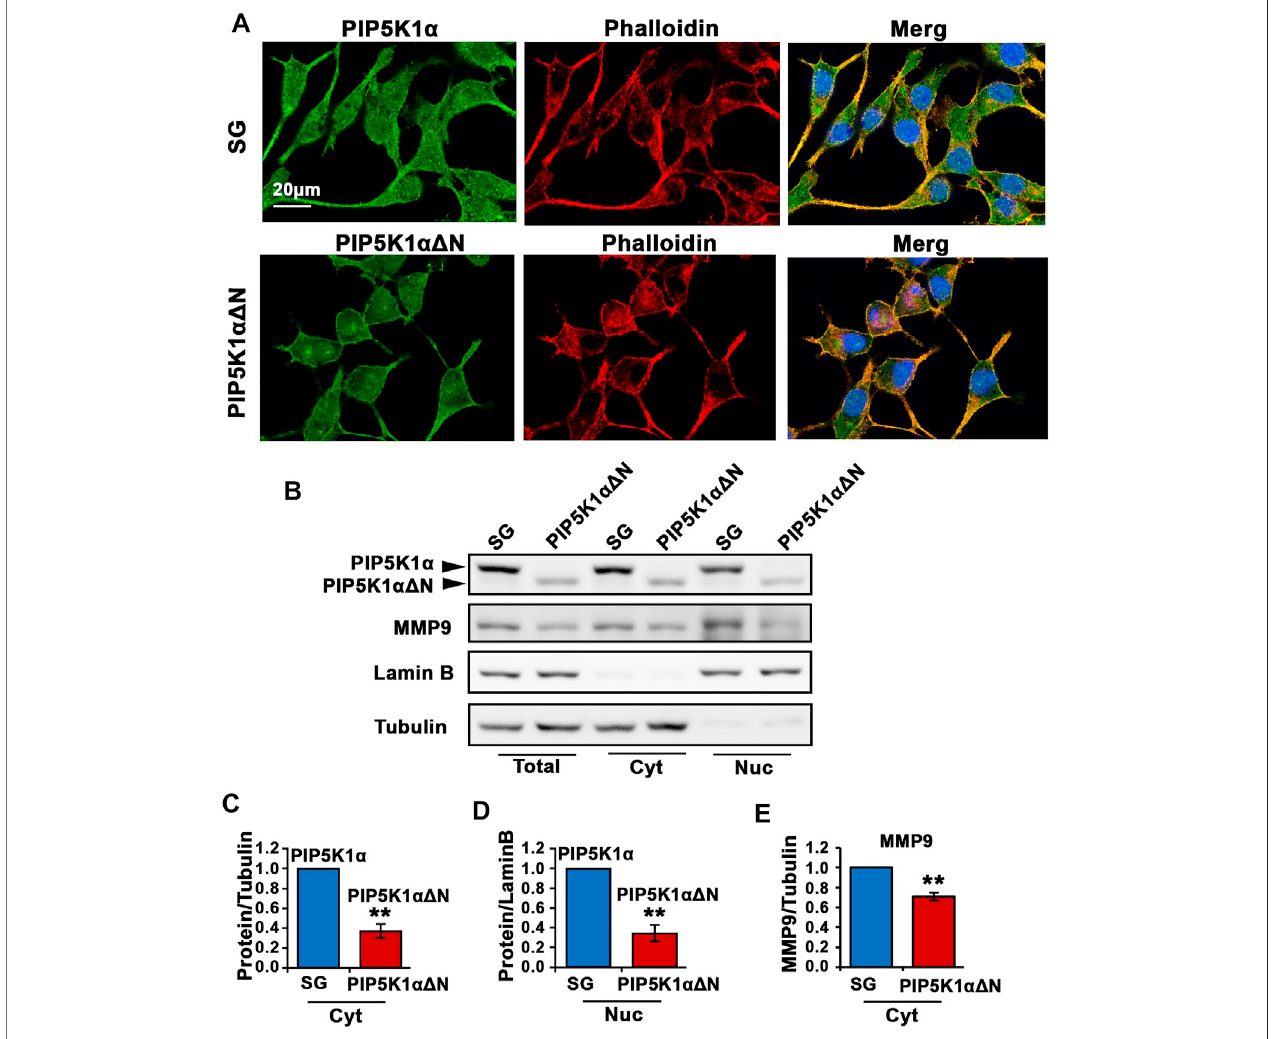
FIGURE 6 | The effect of N-terminal-truncated PIP5K1 α on migratory ability and subcellular components of PIP5K1 αΔ N cells. (A) Representative immuno fl uorescent imagesshowedthesubcellular localizationofPIP5K1 α andPIP5K1 αΔ NingreeninSGand PIP5K1 αΔ Ncells, respectively. Thecellswerestainedby phalloidin in red. Scale bar: 20 μ m. (B) Immunoblot analysis of subcellular localization and expression of PIP5K1 α and MMP9 in SG cells and PIP5K1 αΔ N cells. (C – E) Quanti fi cations of the immunoblots for PIP5K1 α proteins and MMP9 in cytoplasmic (Cyt) and nuclear (Nuc) compartments of SG cells and PIP5K1 αΔ N cells are shown. Data in this fi gure is presented as the average of three independent experiments (±SE). Student ’ s t -test was used in the analysis. ** p < 0.01 is indicated.